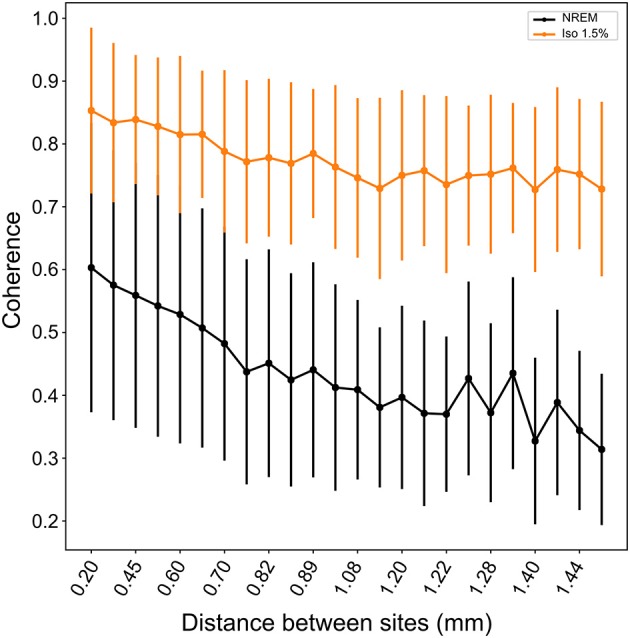
Coherence between neighboring and distance sites during NREM sleep and isoflurane anesthesia: Mean coherence (dots; whiskers are SD) in the 1.5–5Hz frequency band decreases with increasing distance between electrode sites. Nonetheless, coherence is significantly higher under all levels of isoflurane anesthesia (1.5% isoflurane shown here; comparable results for higher isoflurane levels) compared to NREM sleep.